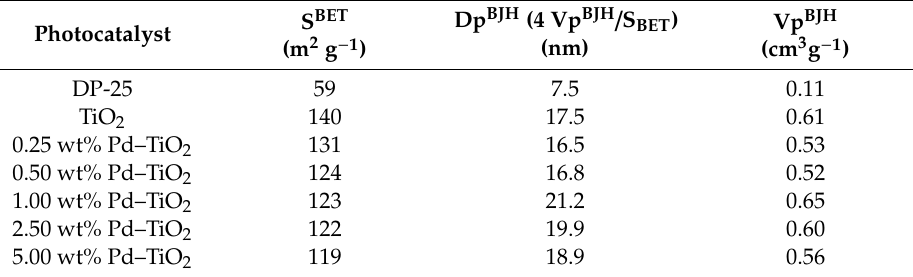
Table 1. Surface Area, Pore Diameter, and Pore Volume of the Prepared